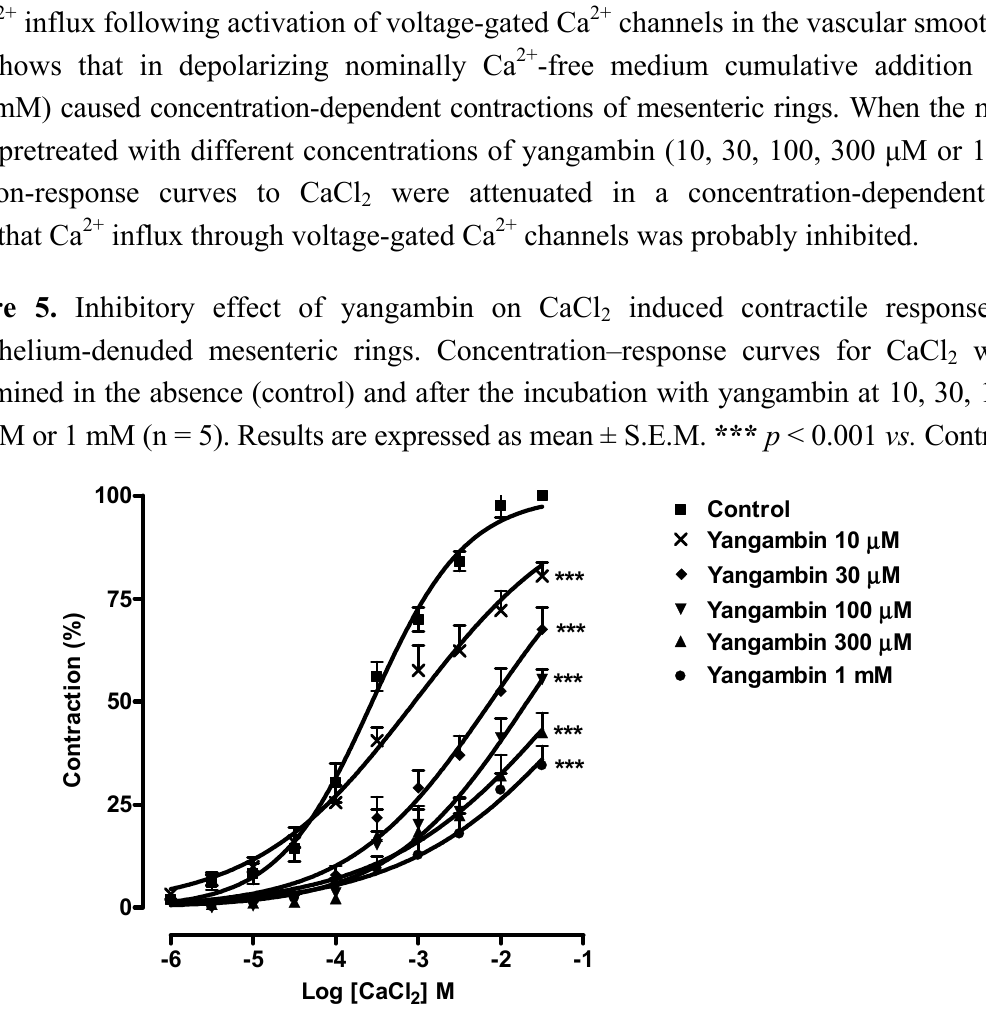
induced contractile response in 2 were 2